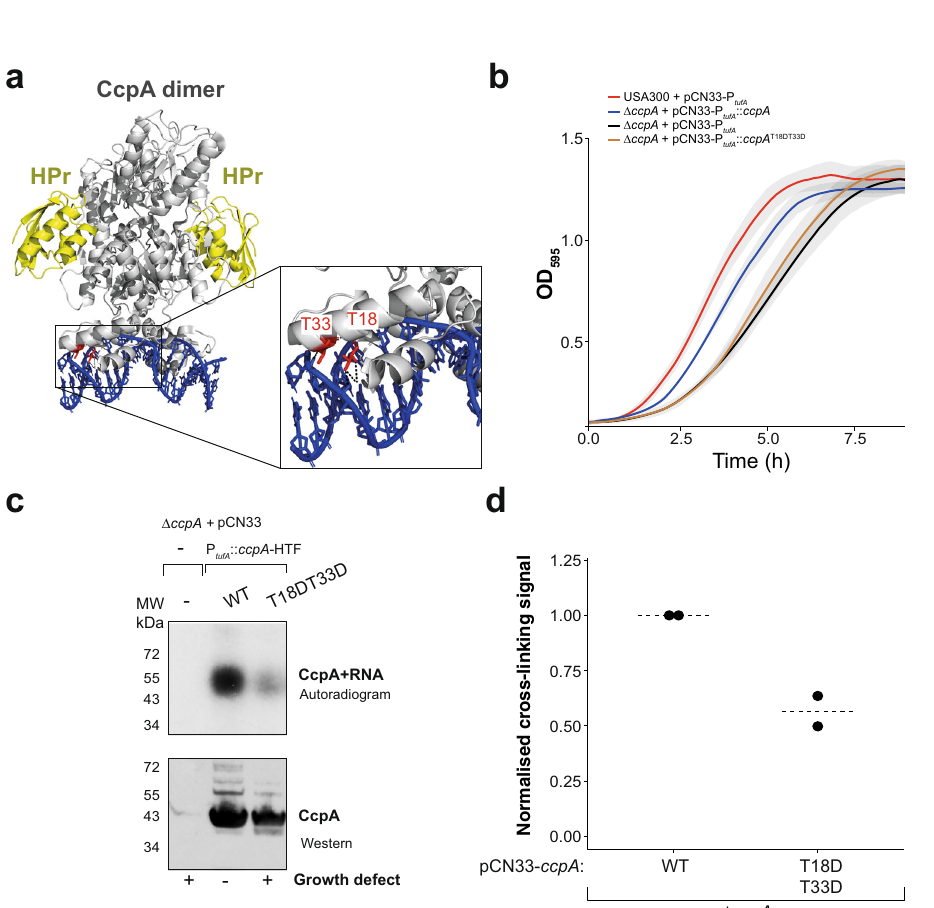
Fig. 6 The CcpA HTH domain is required for ef fi cient RNA-binding in vivo. a Crystal structure of a CcpA-HPr-dsDNA complex (grey, yellow and blue, respectively) containing a 16 bp CRE dsDNA substrate (adapted from 34 ; PDB code 1RZR https://www.wwpdb.org/pdb?id = pdb_00001rzr). The zoomed-in region shows the location of two threonines that are required for dsDNA binding. HPr histidine-containing protein, CRE Catabolite Response Elements. b The CcpA T18DT33D mutation causes a growth defect. Growth curves were performed in a plate reader using the following strains: USA300 + pCN33- P tufA , USA300 Δ ccpA , USA300 Δ ccpA + pCN33-P tufA :: ccpA and the USA300 Δ ccpA + pCN33-P tufA :: ccpA T18DT33D . Data are presented as mean values (solid lines) + / − SD (shaded region). c T18 and T33 are required for ef fi cient RNA-binding in vivo. Shown is a result from a CcpA CRAC experiment using the Δ ccpA as a negative control, the WT CcpA-HTF protein as positive control and the CcpA T18DT33D-HTF mutant. d Quanti fi cation of CcpA-HTF WT and T18DT33D cross-linking data. Autoradiography and Western blot signals from two independently performed CRAC experiments (shown in c ) were quanti fi ed, and the autoradiography signal was normalised to the CcpA protein levels. Original data and pictures for b – d are provided in Source